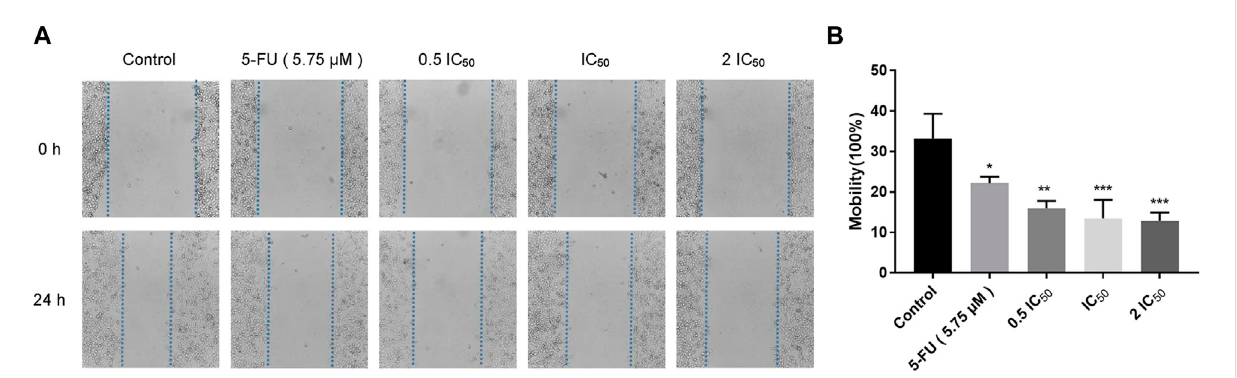
FIGURE 2 Compound 6e inhibited wound healing of KB cells. (A) The wound was captured at different time points (0 h and 24 h). (B) Quanti fi cation of the cell scrape results ( n > 3). *** ( p < 0.001), ** ( p < 0.01), * ( p < 0.05), ns (not signi fi cant).